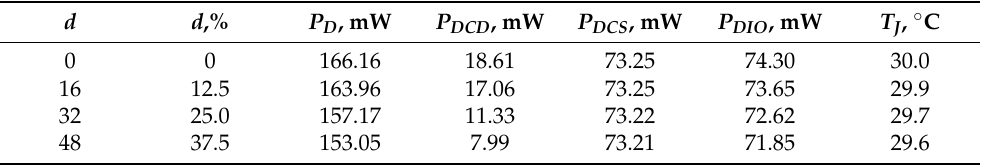
Table 1. Dissipated power and crystal temperature of field-programmable gate array (FPGA) system when n =